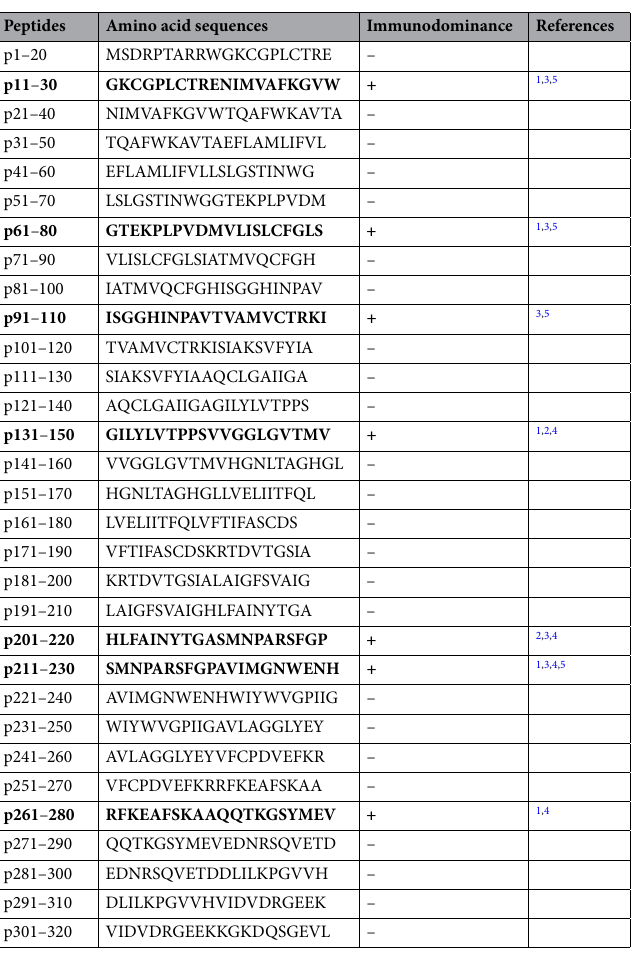
Table 1. AQP4 peptide list. Peptides with a length of 20 amino acids constituting AQP4 molecule (323 amino acids in length) was listed as overlapping by 10 amino acids. AQP4 amino acid sequence of the molecules refers to the UniProt database (AQP4_HUMAN P55087-1). The immunodominant AQP4 peptides are shown in bold